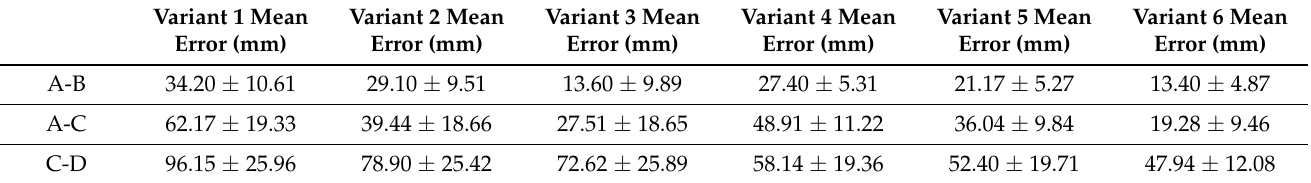
Table 1. Mean error and its standard deviation for different measurement variants.